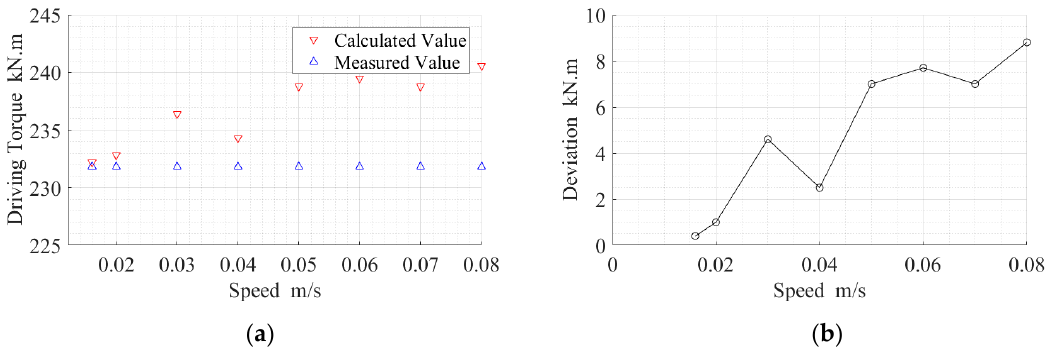
Figure 7. Experimental data of uniform motion, (a) Driving Torque of Calculation and Measuring, (b) Deviation Torque.